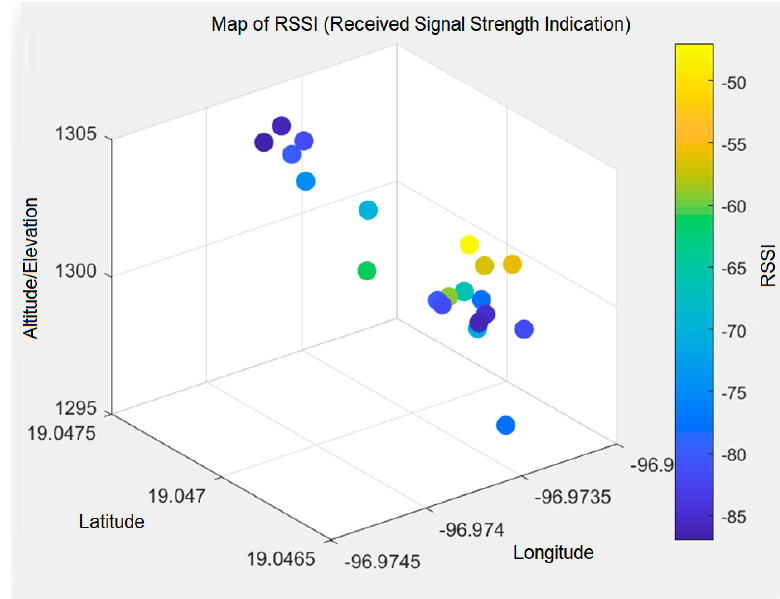
Figure 7. 4D Graph of the access point with position and received signal strength.